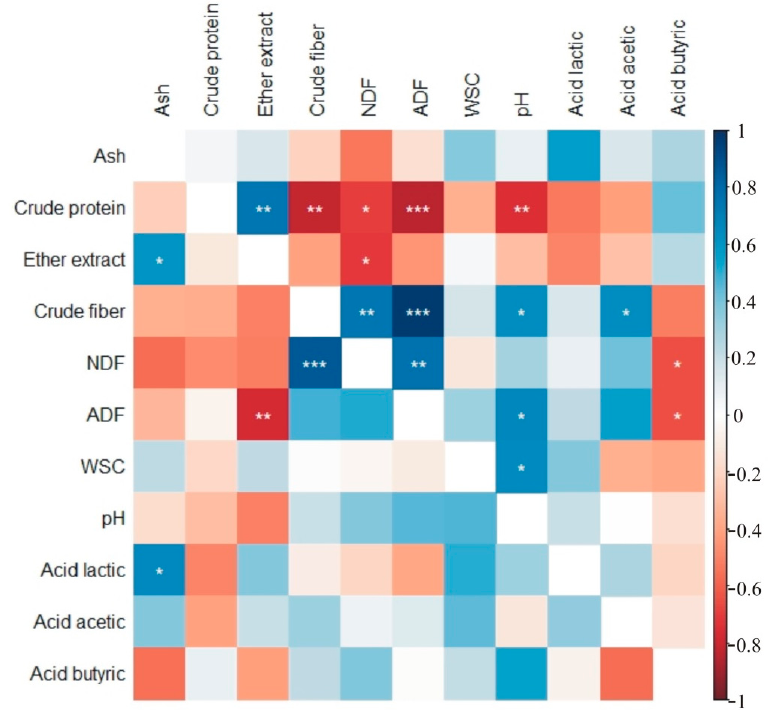
Figure 3. Heatmaps of correlation coefficients for traits of silage treated with microorganisms (above diagonal) and treated with the combined use of microorganisms and amino acids (below diagonal), r cr = 0.576. (NDF — neutral detergent fiber, ADF — acidic detergent fiber, WSC — water-soluble carbohydrates), * p < 0.05, ** p < 0.01, *** p < 0.001.